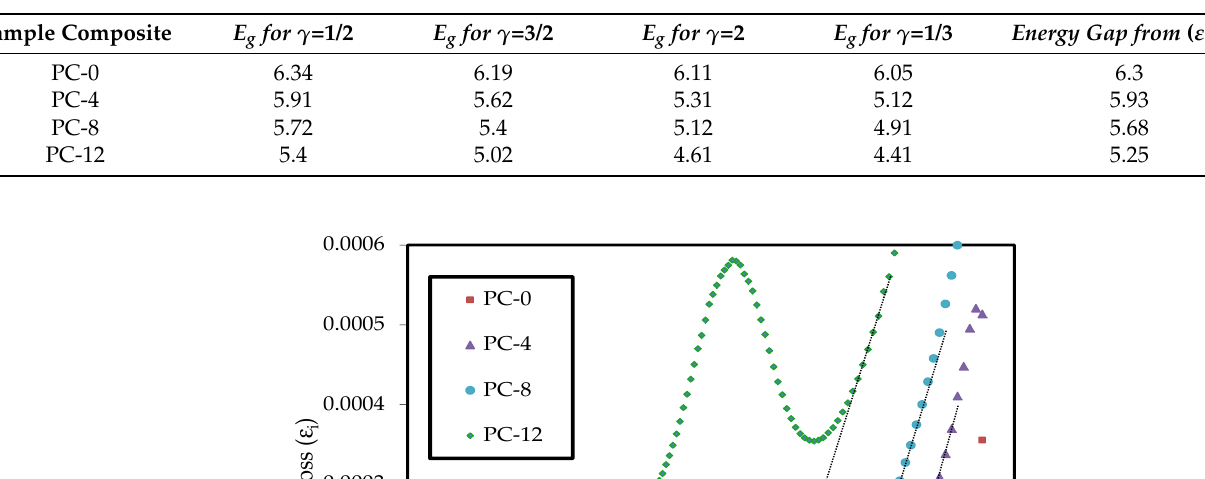
Figure 8. Possible electronic transitions under guiding light through the polymer composite films ( a ) direct allowed, ( b ) direct forbidden, ( c ) indirect allowed, ( d ) indirect forbidden [21,48]. Table 3. Measured E g from Taucand ε i plot. Table 3. Measured E g from Taucand ε i plot.